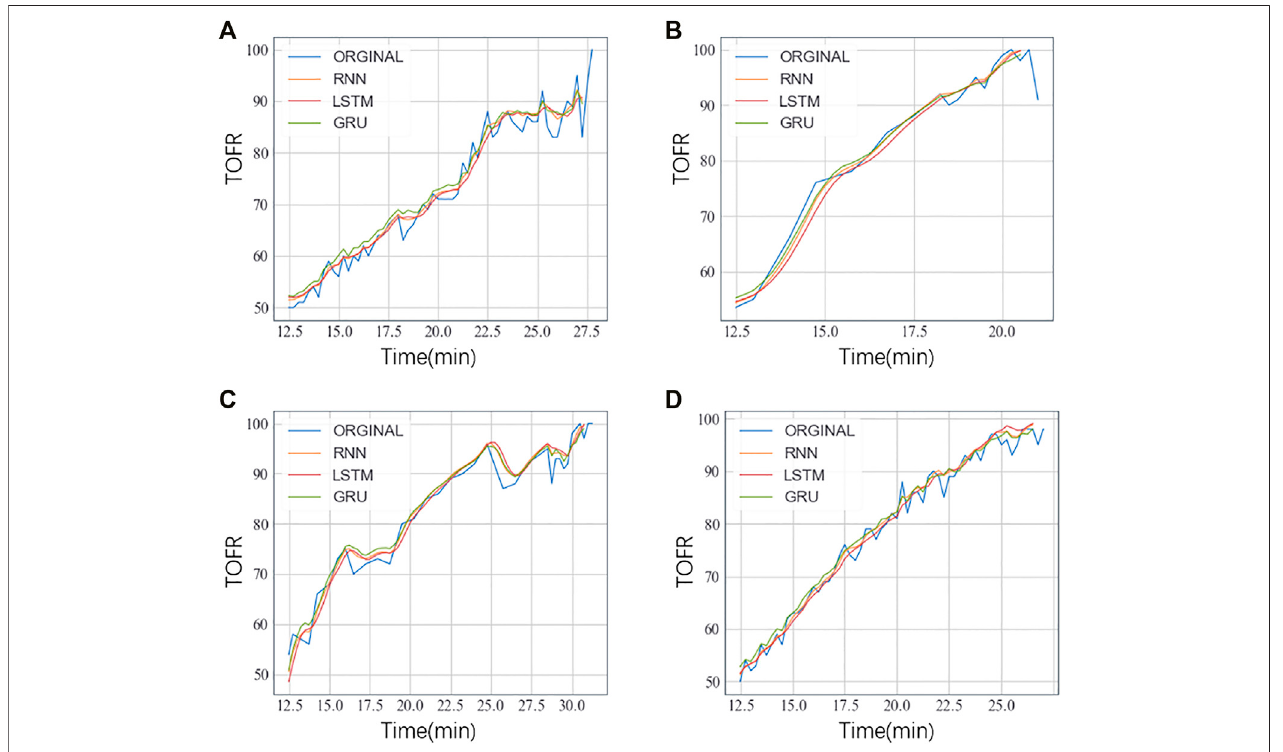
FIGURE 2 | The TOFR curves of four patients (A-D) randomly selected.